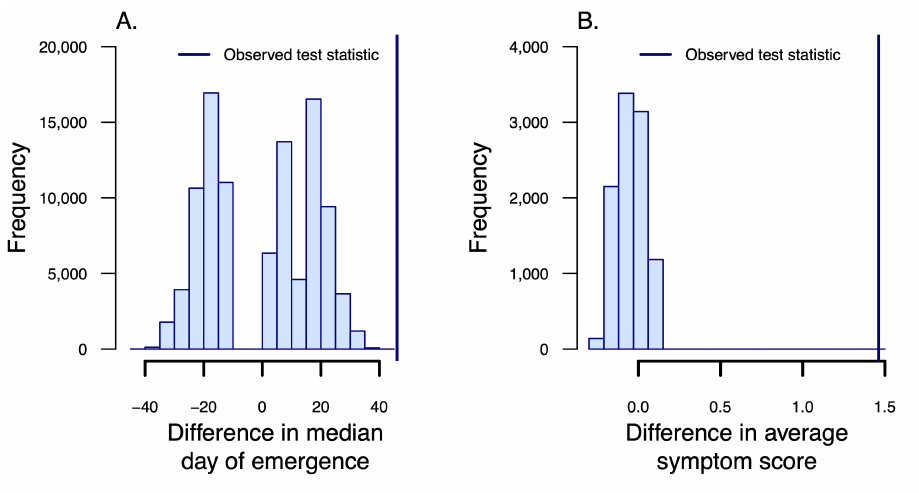
Figure 4. ( A ) Permutation distribution of the difference in median date of symptom emergence among Zion and Black Butte lambs in the first year following M. ovipneumoniae introduction. ( B ) Permutation distribution of the difference in average symptom score among Zion lambs in 2019 and 2020. The dashed vertical line shows the observed difference relative to the randomization distribution in each